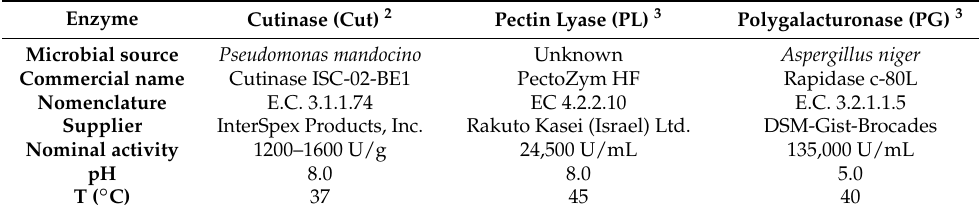
Table 2. Specification of enzymes employed for scouring trials 1 .